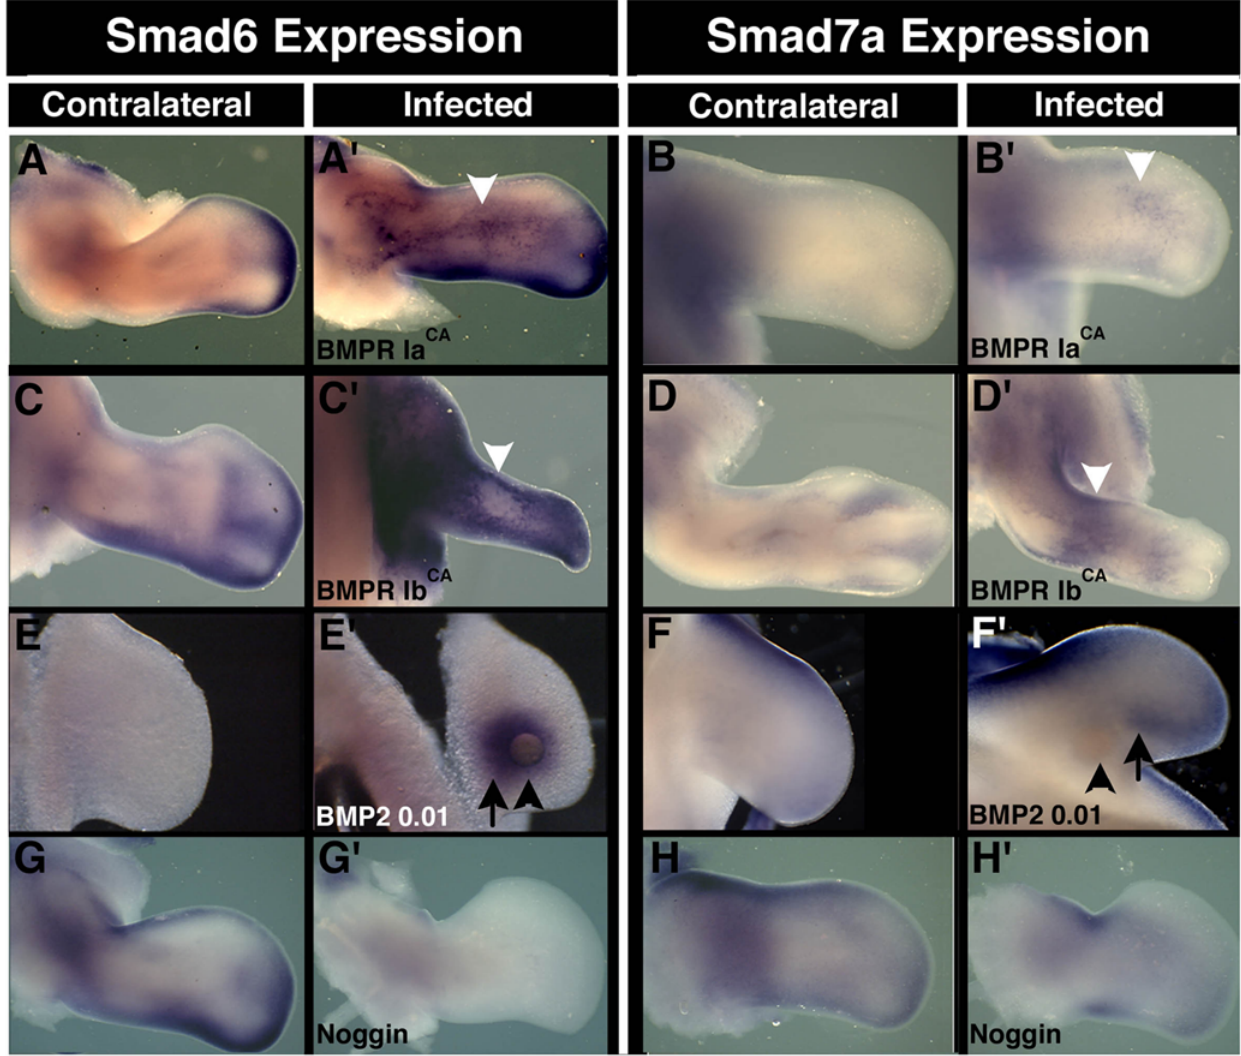
Figure 5. Regulation of negative Smad gene expression by BMP signaling. Expression patterns of cSmad6 in contralateral (A, C, E, G) or manipulated (A’, C’, E’, G’) limbs and of cSmad7a in contralateral (B, D, F, H) or manipulated (B’, D’, F’, H’) limbs. (A’–D’, G’–H’) virus infection at HH St17–20, fixed after 48 hr. (E’–F’) BMP2 protein soaked bead implanted into proximal mesenchyme at HH St20, fixed at 15 hrs. Experimental manipulation as indicated on panels. Note ectopic expression of cSmad6 and cSmad7a following BMPR Ia CA and BMPR Ib CA misexpression (white arrowheads); position of heparin sulphate bead (black arrowhead) and resulting ectopic expression (black arrow). Reduction in limb size in C’ and D’ is due to cell death induction caused by BMPR Ia CA misexpression and is not a photographic artifact. All images show dorsal surface. Anterior to top, distal to right. Scale bars 500 m m.